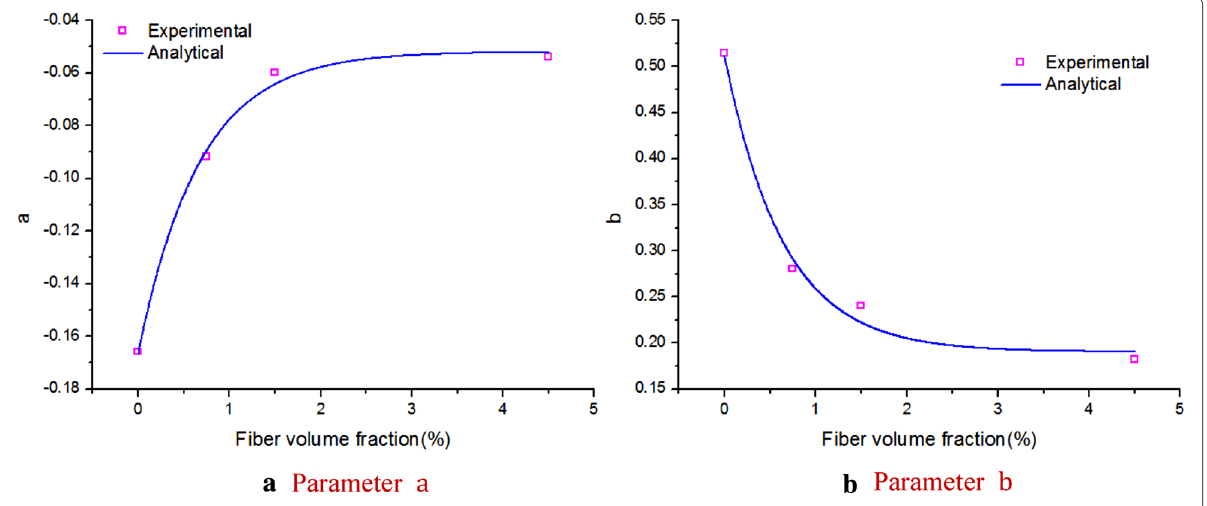
Fig. 19 Values of parameters a and b .